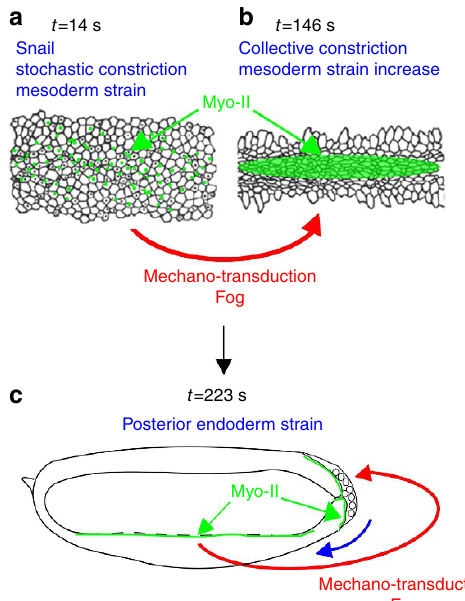
Figure 8 | Meso-endoderm mechanotransductive cascade of Myo-II apical stabilization. ( a ) Sna -dependent stochastic fluctuation of mesoderm apex size ( b ) activates the medio-apical accumulation of Myo-II in a Fog-dependent mechanotransductive process leading to